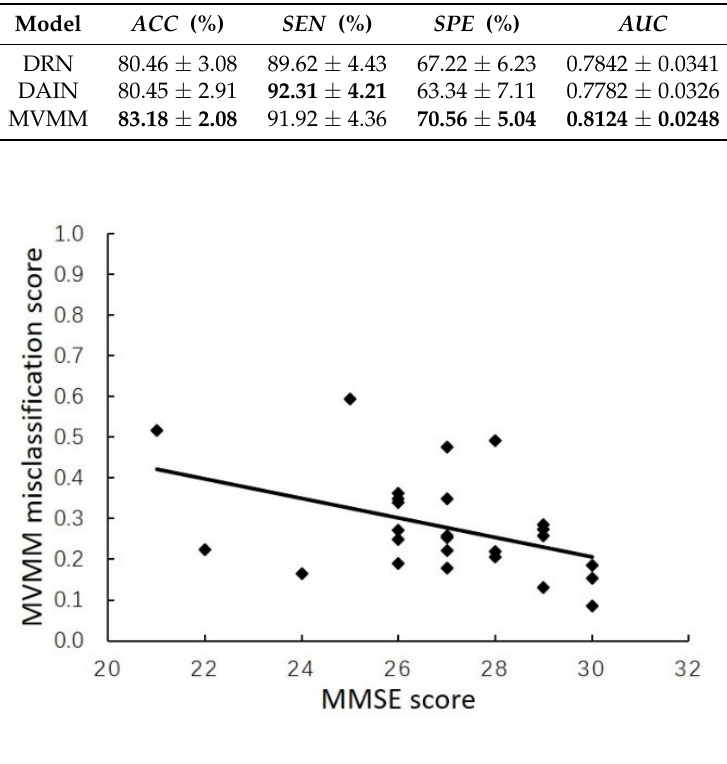
Table 3. Classification performance of different views for T2 task.